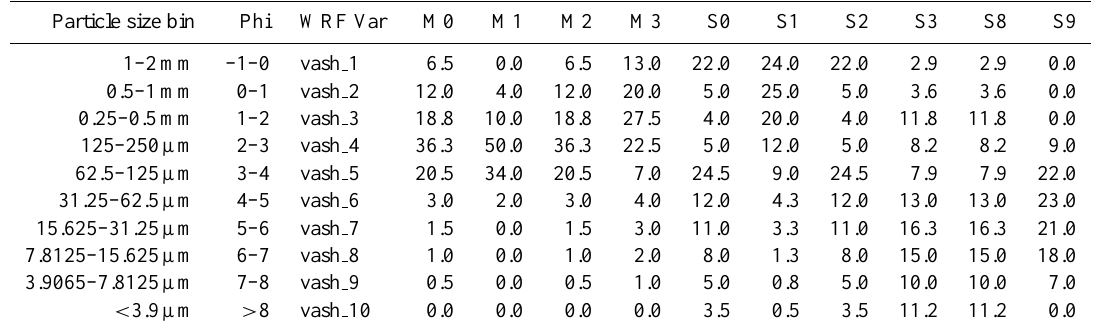
Table 2. Ash particle bin size ranges with corresponding WRF-Chem variable names; the mass fractions in percent of total mass are given below each ESP eruption type M0–M3 and S0–S9.